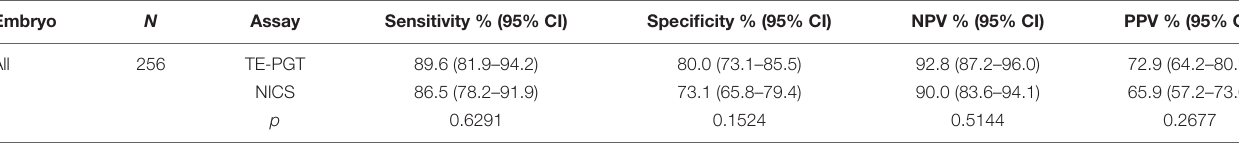
FIGURE 3 | The demonstration of CNV profiles. The profiles generated from the NGS data of whole embryo, TE cells, and NICS were graphed and compared for each embryo. (A) The embryo shows consistent euploid karyotype of [46, XX] in all three assays. (B) The embryo shows consistent aneuploid karyotype of [48, XY, +6, +20] in all three assays. (C) The whole embryo and TE cells indicate a normal karyotype of [46, XX]; however, NICS shows multiple abnormal chromosomes (MAC). (D) The embryo shows consistent profile of [46, XY, +16q (q11.2 → qter, ∼ 47M)] in whole embryos and NICS assay; however, the TE cells show multiple abnormal chromosomes. TABLE 1 | The performance of TE-PGT versus NICS on detecting chromosomal